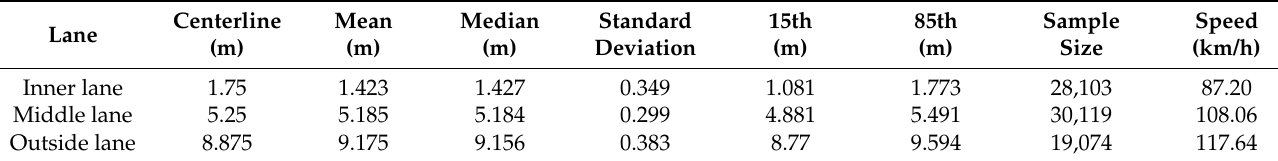
Figure 8. Preferred trajectory distribution of six-lane divided freeways. Table 3. Characteristic value of preferred trajectory deviations for four-lane divided freeways.